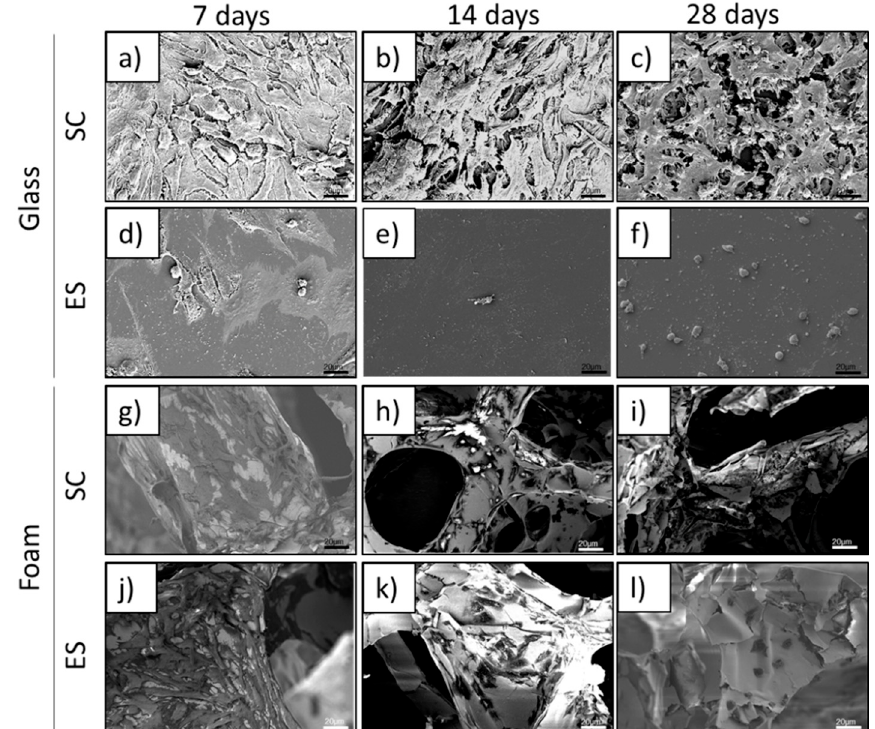
Figure 3. SEM images of human Saos-2 cells cultured for 7, 14 and 28 days under standard conditions (SC) or electrical stimulation (ES) on either glass coverslips ( a – f ) or Pd-coated PU foams ( g – l ).